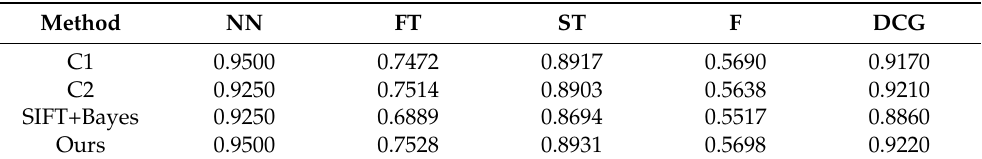
Table 1. The five evaluation criteria of each step of our method.